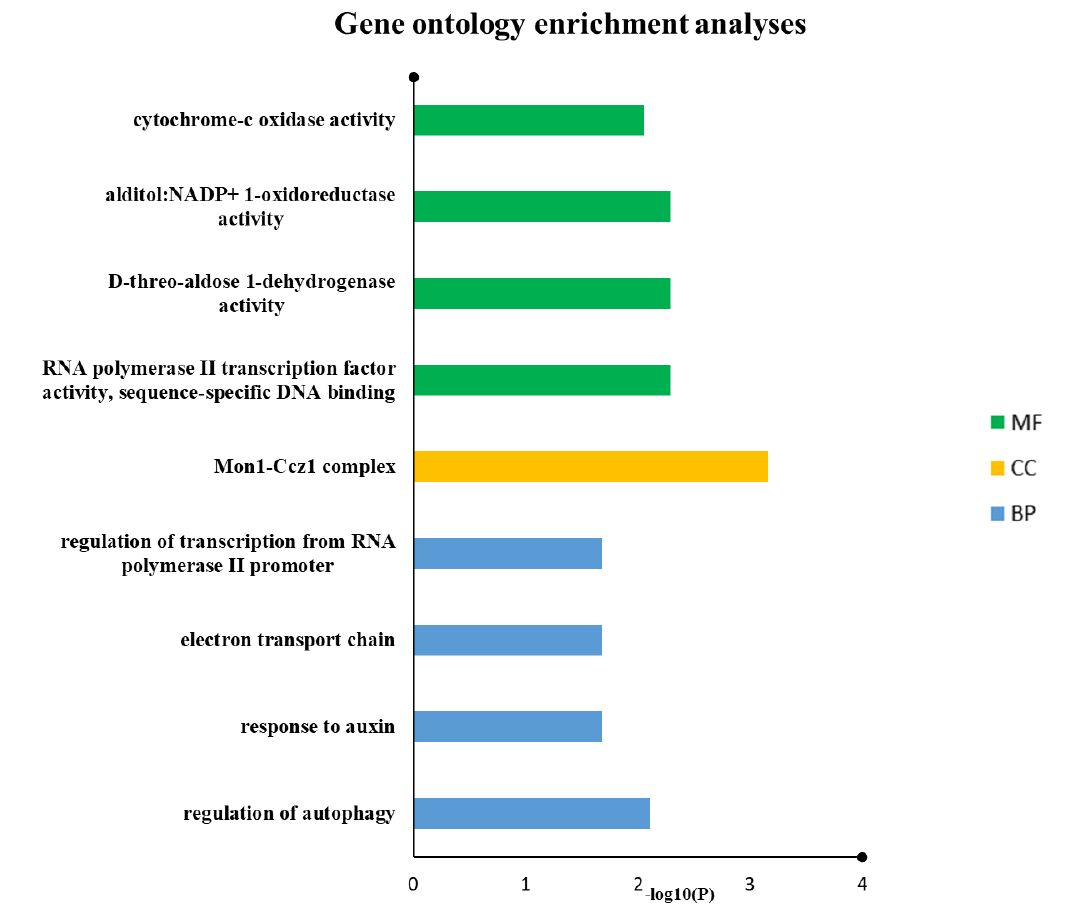
Figure 6. Drought proteins were annotated using reference genome of wheat from IWGSC. Predicted biological mechanisms indicated that auxin-related response, autophagy, electron transport chain and transcription regulations are prominent in this study.